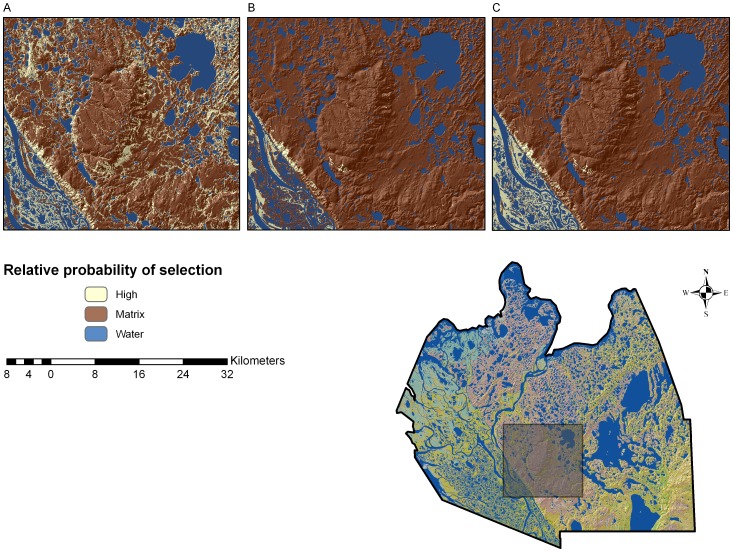
Relative probability of selection.Select portion of study area showing seasonal changes in relative probability of selection of cover for female grizzly bears monitored from 2003–06. A) den-emergence to end of week 31 (ca. 4 August, season 1); B) week 32 to the end of week 39 (ca. 29 September, season 2); and C) week 40 to the den-entry (season 3). Lower right inset shows location of highlighted portion of the Mackenzie Delta study area.